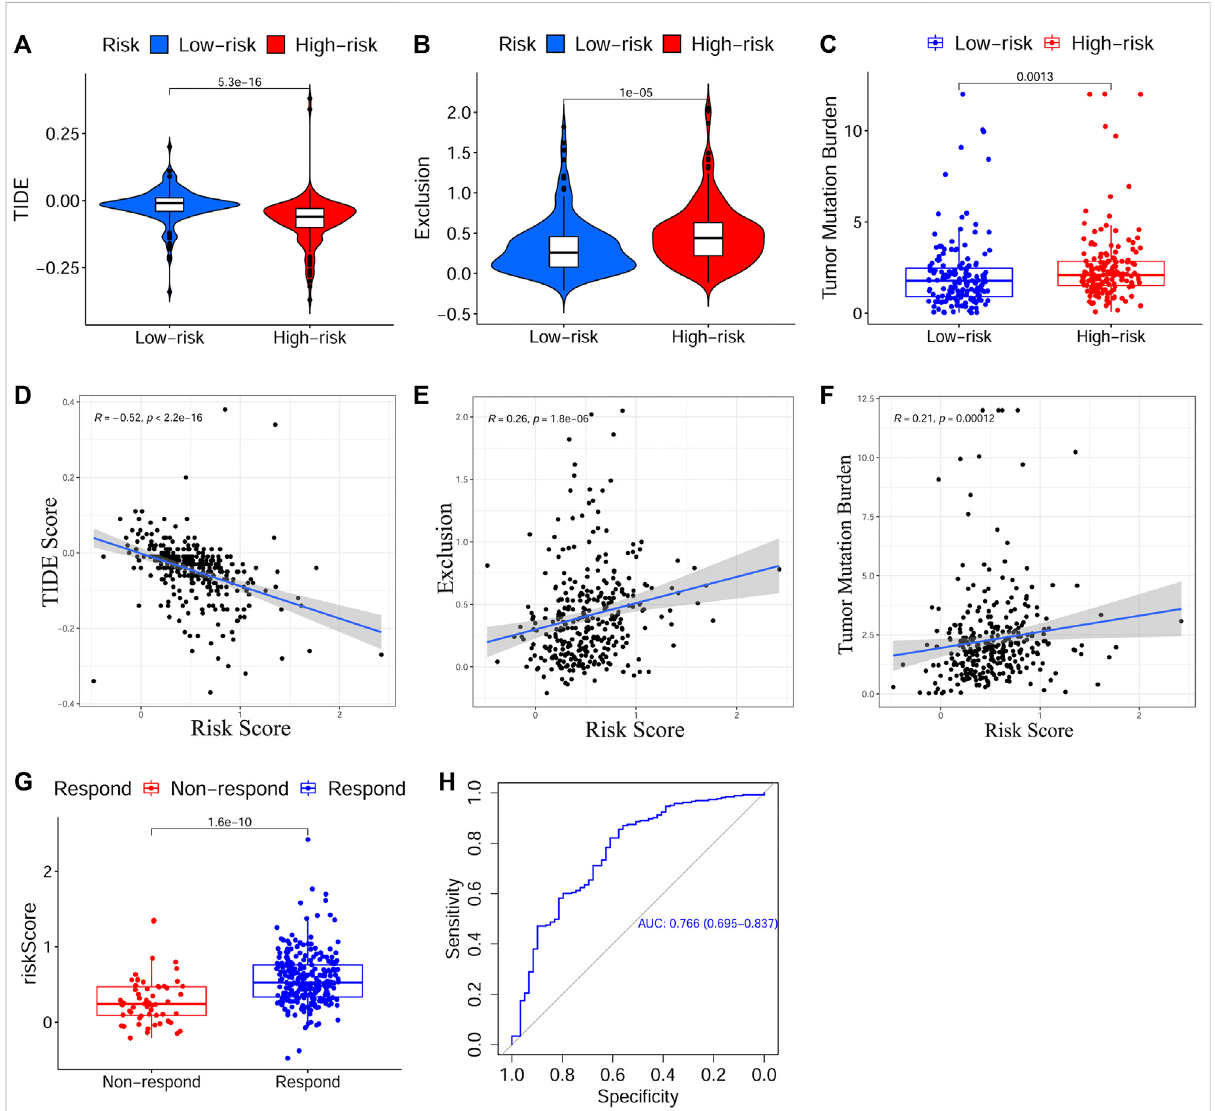
FIGURE 7 EvaluationofthepredictiveeffectoftheprognosticsignatureonICItreatmentresponse. (A – C) ThescoresofTIDE,immuneexclusionandTMB in different risk subgroups. (D – F) The relationship between the risk score and the score of TIDE, immune exclusion and TMB. (G) Predicted ICI treatment responses in different risk subgroups based on TCGA cohort using TIDE algorithm. (H) The ROC curve and AUC value to estimate the accuracy of the signature for predicting ICI treatment response. ICI, Immune checkpoint inhibitor, TIDE, Tumor Immune Dysfunction and Exclusion, TMB, Tumor Mutation Burden, TCGA, The Cancer Genome Atlas, ROC, Receiver operating characteristic, AUC, Area under